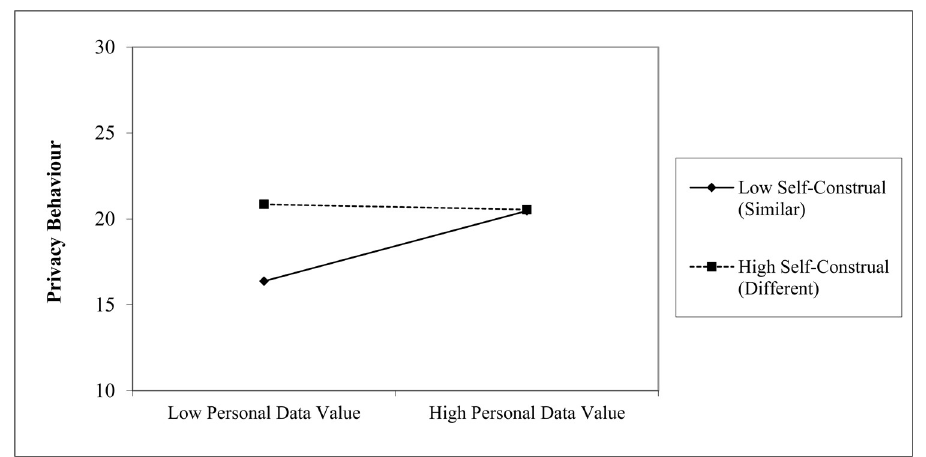
Fig 2. Simple slope of value by self construal. Points plotted on the x-axis are one SD above and below the mean.